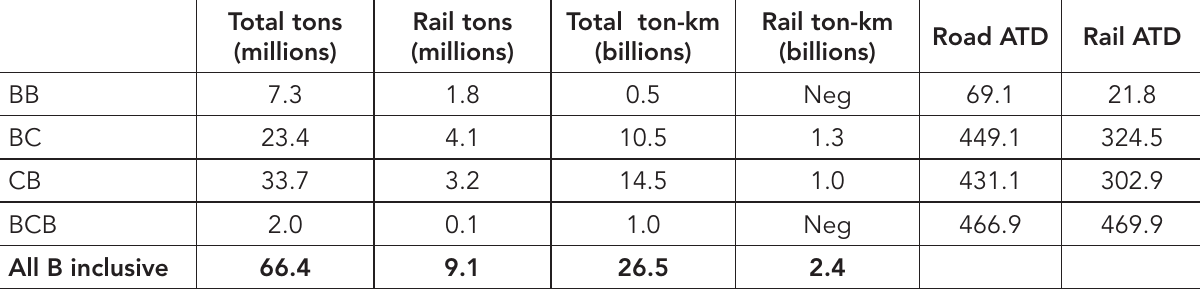
Table III: Rail market share of potential branch line traffic (data source: FDM, 2009)